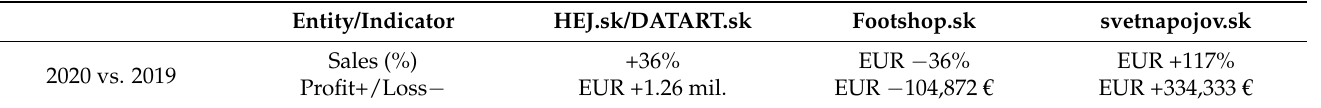
Table 5. Sales and profit: 2020 vs.